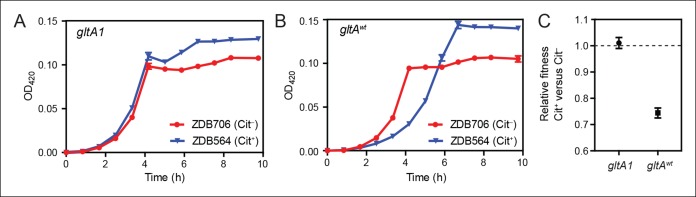
Evolution of citrate utilization was potentiated by the gltA1 mutation. (A) Growth curves for an early Cit+ clone (ZDB564) from the LTEE which contains the gltA1 mutation and an isogenic Cit– revertant of this strain (ZDB706) without the citT amplification, grown in DM250 medium. The presence of the citT mutation, which is sufficient for the rudimentary Cit+ trait on its own, slightly improves the growth dynamics and final cell density in this genetic background that includes gltA1 and other evolved alleles. Error bars are the S. D. of at least three replicates. (B) Growth curves of isogenic derivatives of strains ZDB564 and ZDB706 in which the gltA1 mutation has been reverted to the wild-type sequence, performed in DM250 medium. Addition of the citT amplification in this gltAwt genetic background now causes a large lag in growth dynamics although the final cell density achieved is still higher in the Cit+ strain. Error bars are the S. D. of at least three replicates. (C) Relative fitness values as determined by competition assays between Cit+ (ZDB564) and Cit– (ZDB706) isogenic strain pairs which contain either the gltA1 or gltAwt allele. Competitions were performed in DM25 medium, which was used throughout the LTEE. In accordance with the growth curves, these competitions show that the citT mutation would be highly deleterious to fitness if it evolved in a genetic background without the gltA1 mutation. In contrast, the citT mutation is neutral or possibly slightly beneficial to fitness when the gltA1 mutation is present. Thus, the gltA1 mutation potentiated the eventual evolution of robust citrate utilization (Cit++) by preventing the citT mutation from having deleterious effects when it first appeared. Error bars are 95% confidence limits from six replicate assays.